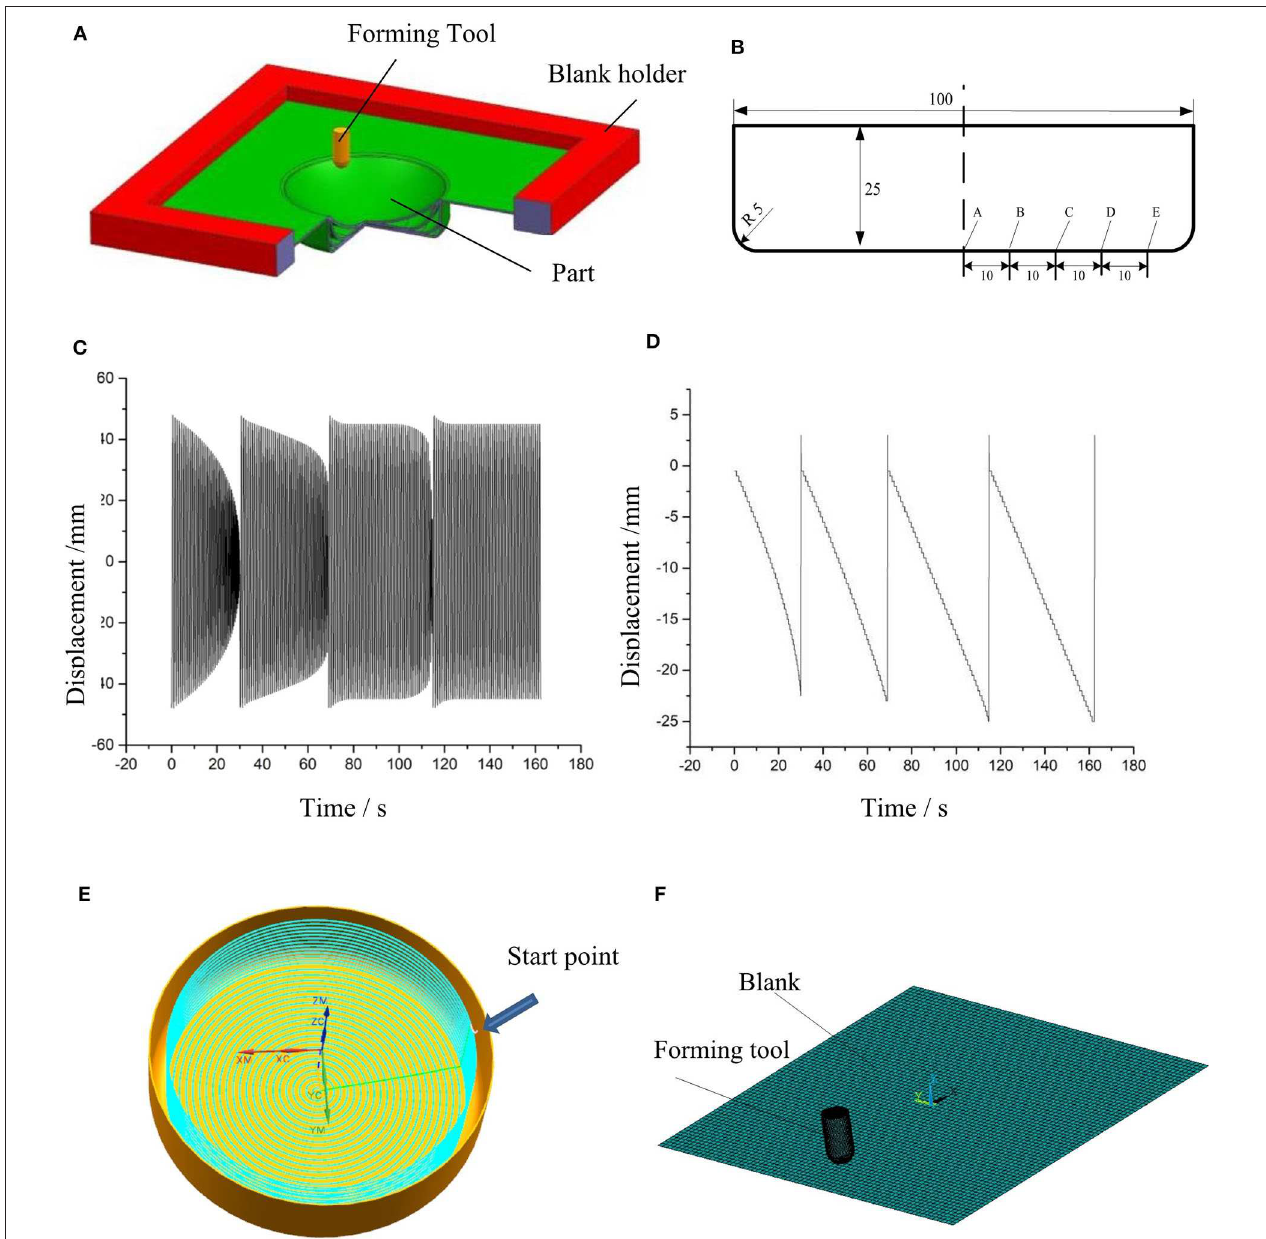
FIGURE 3 | Models and measuring position diagram: (A) setup of multistage SPIF; (B) dimensions of the part and illustration of measuring point positions; (C) displacements in X and Y direction with time; (D) displacement in Z direction with time; (E) the tool trajectory at final stage of the part; (F) mesh model of the blank and